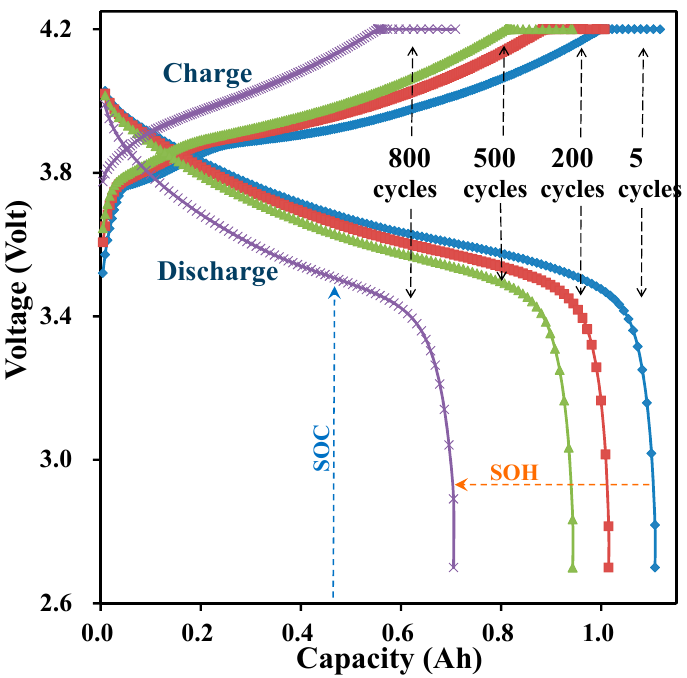
Figure 1. Variations of the voltage vs. capacity of cell A at various cycles.